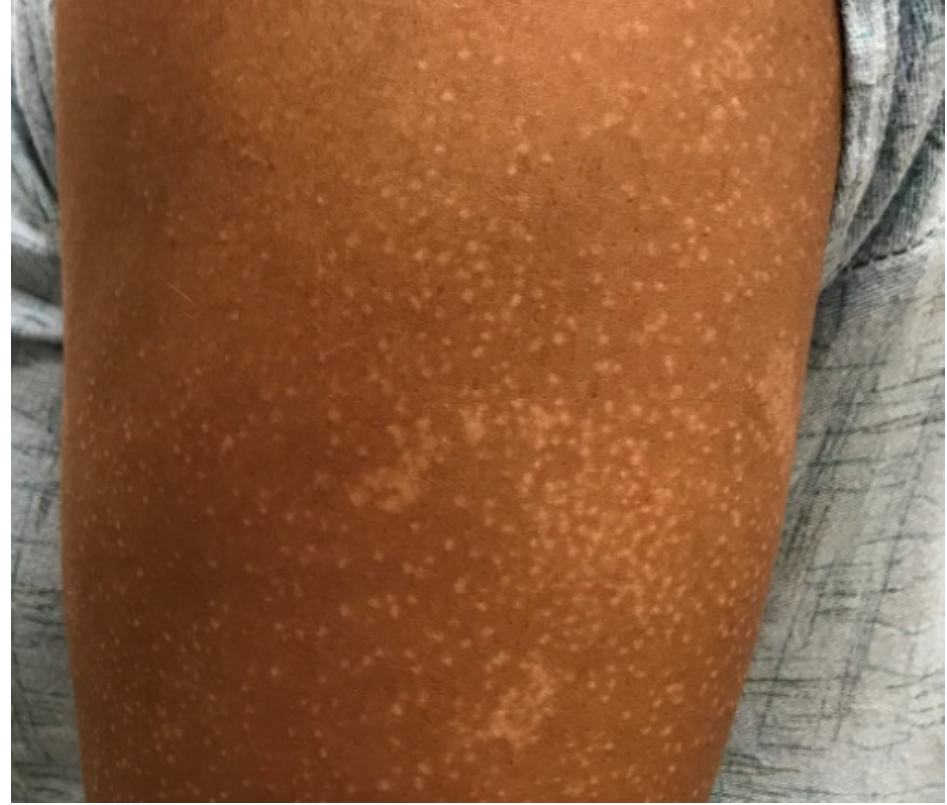
Figure 2. Mycosis fungoides presenting as hypopigmented macules and patches in the upper extremity of an African American patient.